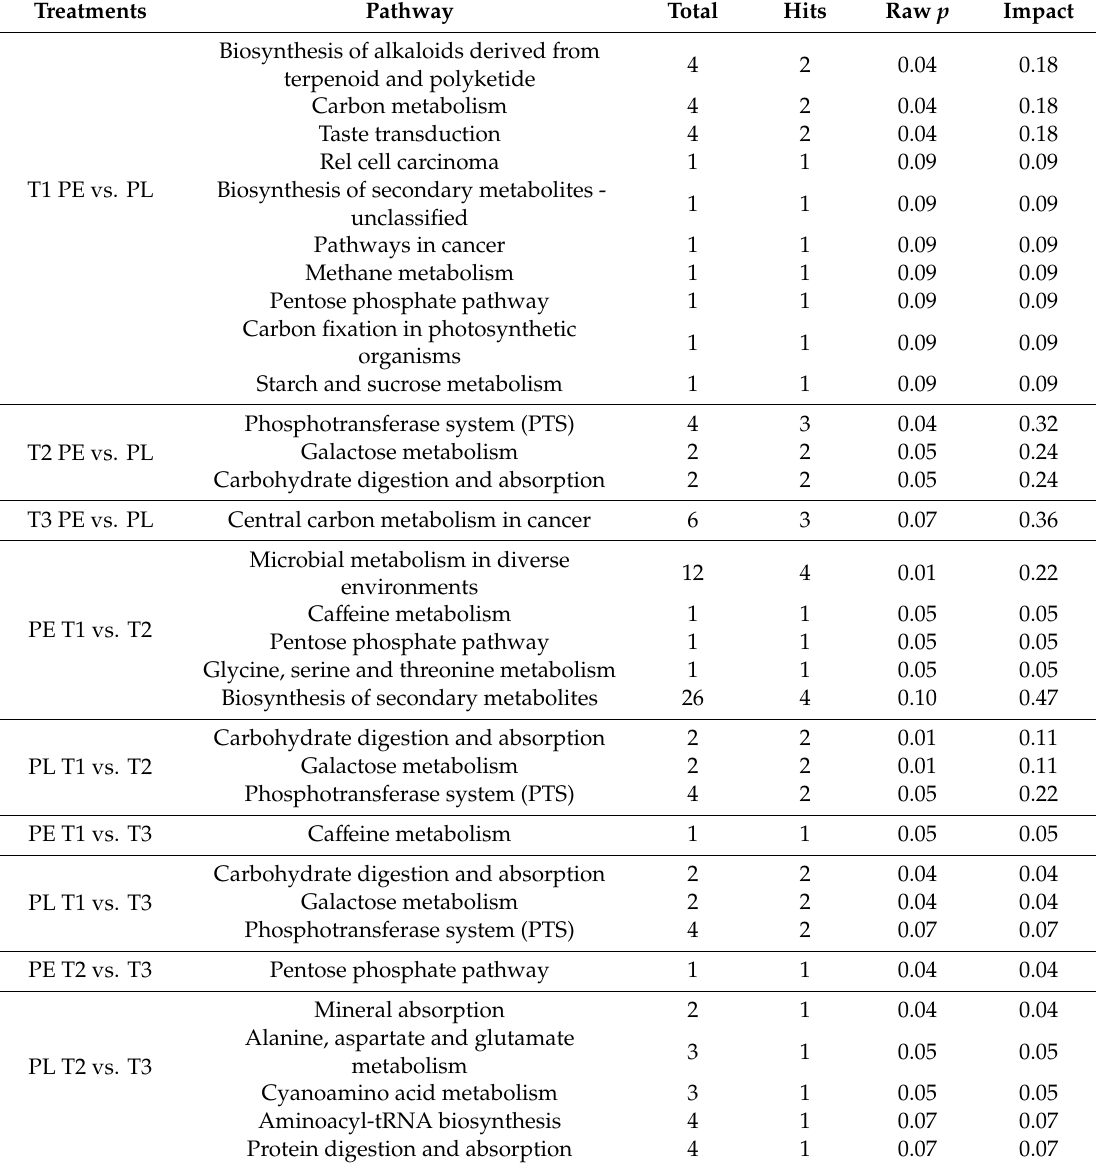
Table 2. Metabolic pathway analysis from the Kyoto Encyclopedia of Genes and Genomes (KEGG). Treatments Pathway Biosynthesis of alkaloids derived